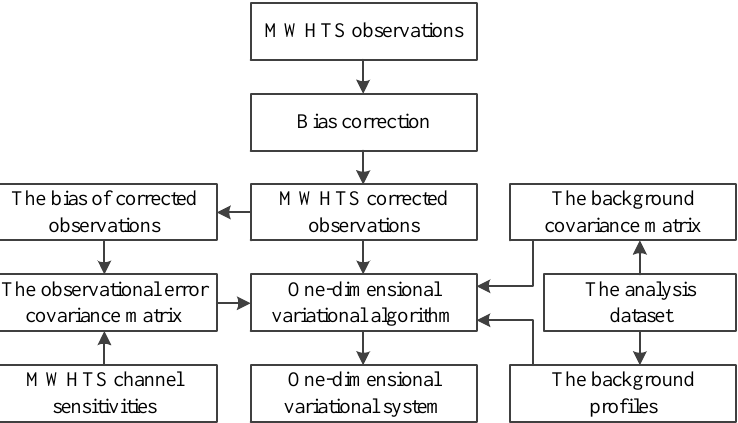
Figure 5. The schematic of building the MWHTS 1DVAR retrieval